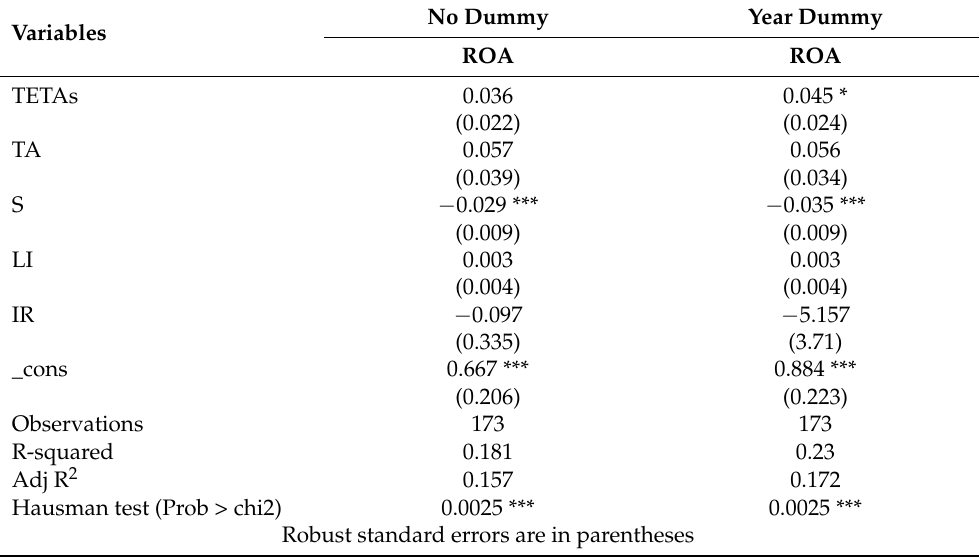
Table 20. Results of the Fixed Effects of TETAs on ROA, as per Panel Data Regression (Profit-Making